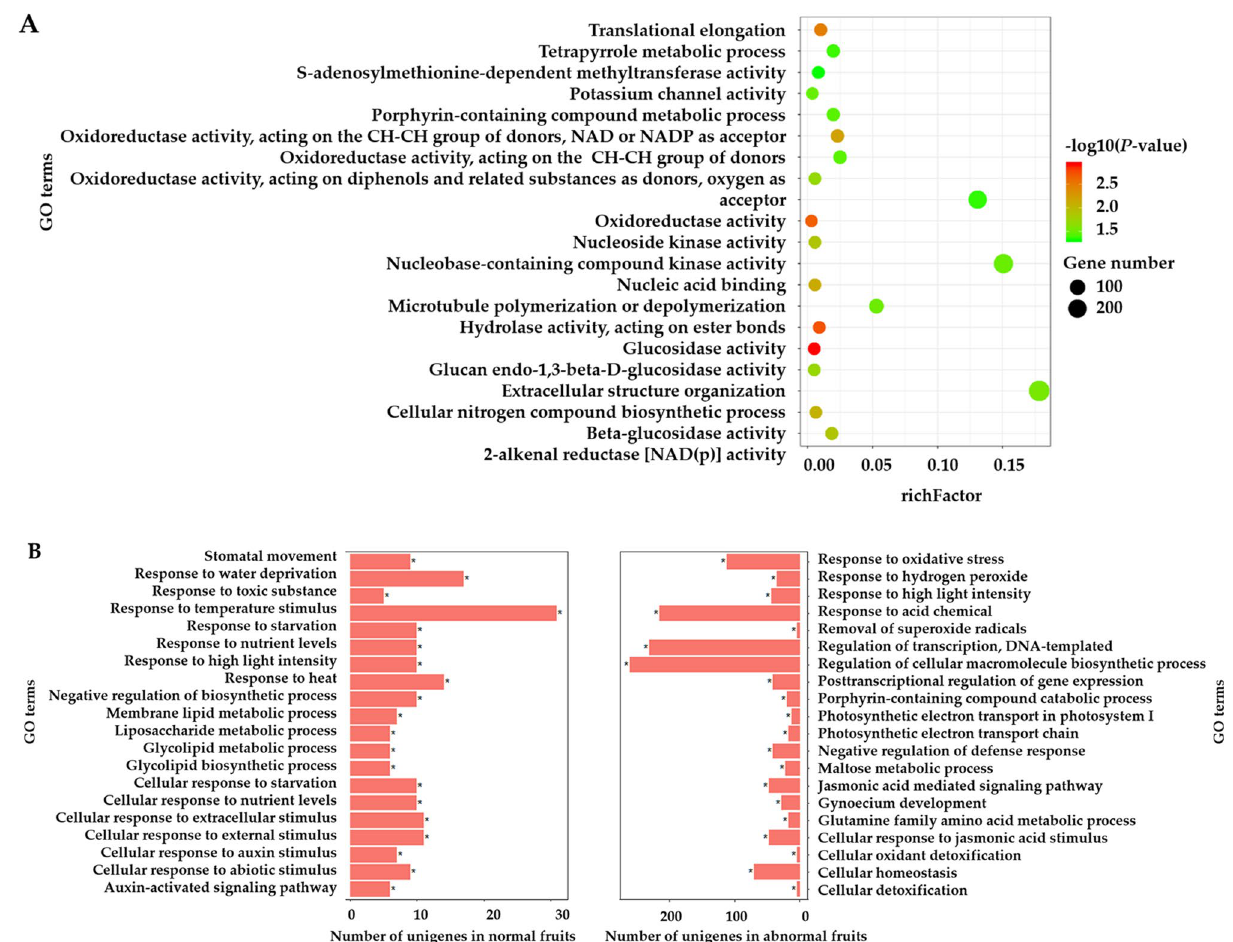
Figure 5. ( A ) Functional enrichment analysis of normal-abnormal differentially expressed genes at 17 DAF; ( B ) Functional enrichment analysis of stage-specific genes in normal and abnormal fruits,